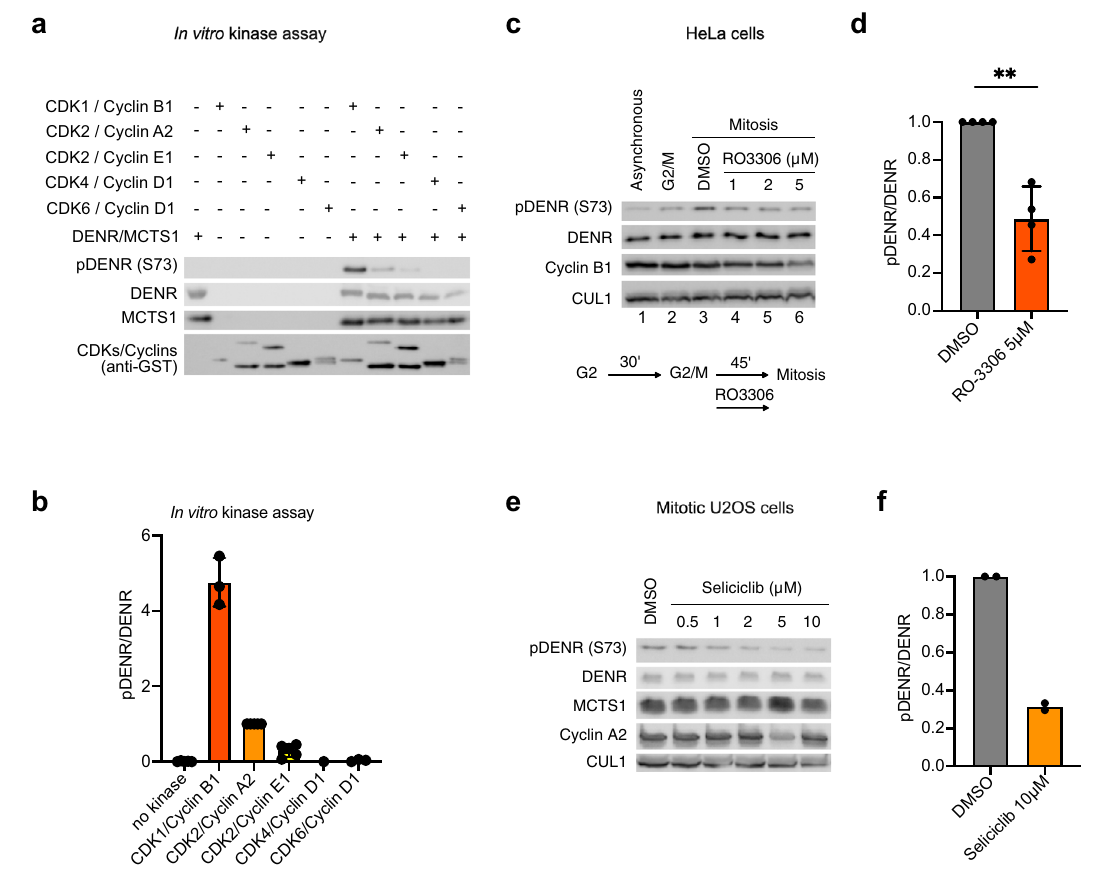
Fig. 2 Cyclin B/CDK1 and Cyclin A/CDK2 phosphorylate DENR at Ser73 in mitosis. a In vitro kinase assay using active recombinant Cyclin B1/CDK1, Cyclin A2/CDK2, Cyclin E1/CDK2, Cyclin D1/CDK4 or Cyclin D1/CDK6 (as indicated) on puri fi ed DENR·MCTS1 protein complex and analyzed by Western Blot shows phosphorylation of DENR Ser73 by Cyclin B1/CDK1 and Cyclin A2/CDK2. b Quanti fi cation of biological replicates of the experiment shown in Fig. 2a. Indicated are averages and standard deviations as error bars. n = 5 for no kinase and CDK2/CycA (orange), n = 4 for CDK2/CycE1 (yellow), n = 3 for CDK1/CycB (red) and CDK6/CycD1, n = 1 for CDK4/CycD1. c Mitotic DENR phosphorylation is reduced upon CDK1 inhibition. HeLa cells were synchronized at end of G2, followed by release and — 30 min later — addition of either DMSO or the CDK1 inhibitor RO3306 for 45 min and DENR phosphorylation was assessed by immunoblotting. d Quanti fi cation of n = 4 independent biological replicates of the experiment performed as indicated in c with DMSO gray and RO3306 red. Error bars indicate standard deviation and one sample t -test was performed with ** p = 0.009. e CDK2 inhibition using seliciclib reduces DENR phosphorylation at Ser73 in U2OS cells that were synchronized in mitosis using a 13 h-release from double thymidine block. DMSO or the indicated doses of seliciclib were added to the cells for the last 4 h. f Quanti fi cation of n = 2 independent biological replicates performed as described in e with DMSO gray and seliciclib